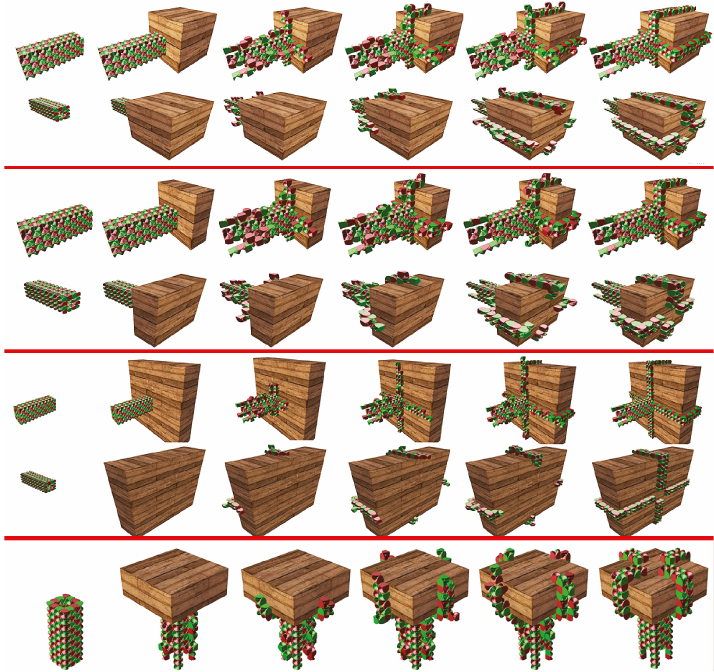
Figure 14: Environmentally sensitive recon fi guration of touching object in di ff erent